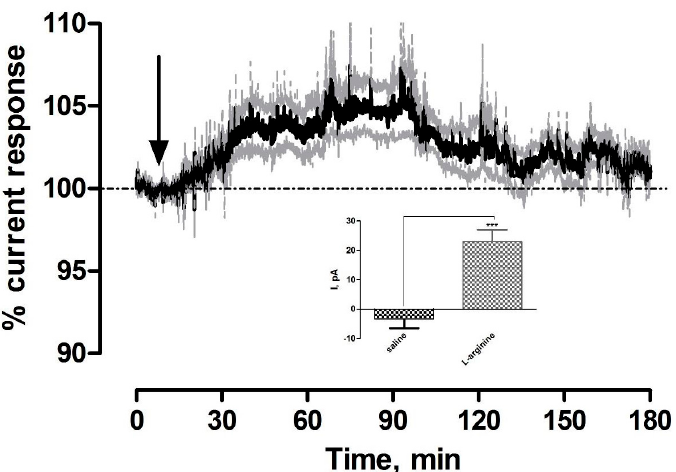
Figure 3. Averaged raw data % current response of NO sensors implanted in the striatum of NOD SCID mice to a 200 mg·kg − 1 injection of L -arginine ( n = 5). Arrow indicates point of injection. Mean % current response represented by black trace, % error represented by grey trace. Inset: Comparison of Δ I for saline control vs. L -arginine ( p < 0.001), unpaired t -test ( n = 5). Data represented as Δ I ± SEM as compared to baseline. * denotes level of significance